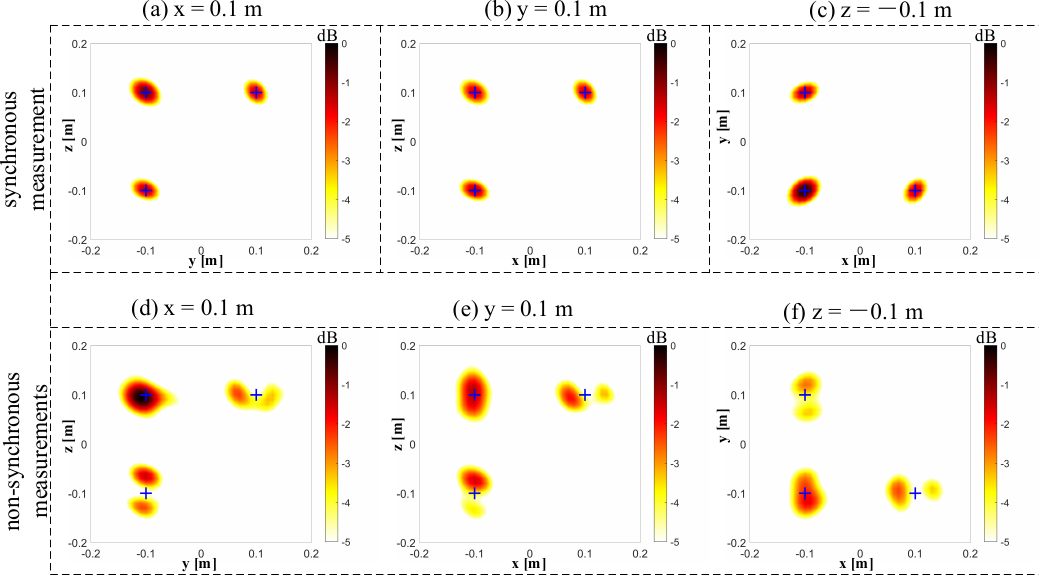
Figure 12. The beamforming results of the synchronous and non-synchronous measurements at 4000 Hz. ( a ) The beamforming map of the synchronous measurement at the x = 0.1 m slice. ( b ) The beamforming map of the synchronous measurement at the y = 0.1 m slice. ( c ) The beamforming map of the synchronous measurement at the z = − 0.1 m slice. ( d ) The beamforming map of the non-synchronous measurements at the x = 0.1 m slice. ( e ) The beamforming map of the non-synchronous measurements at the y = 0.1 m slice. ( f ) The beamforming map of the non-synchronous measurements at the z = − 0.1 m slice.